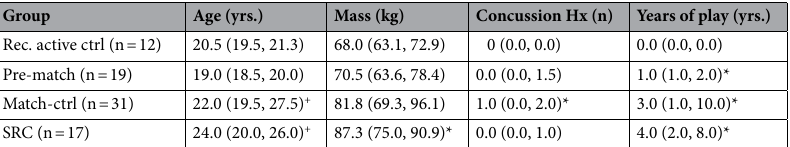
Table 2. Descriptive statistics for combined sex data. Subjects were all Caucasian. All data reported as median(Q1, Q3). Rec. Active Ctrl = Recreationally active control group, Match-Ctrl = Match-Control group, SRC = Sport-related Concussion group, Hx = history, Q1 = 1st quartile, Q3 = 3rd quartile. * = statistically different compared to recreationally active control group (p < 0.05), + = statistically different compared to pre- match (p <